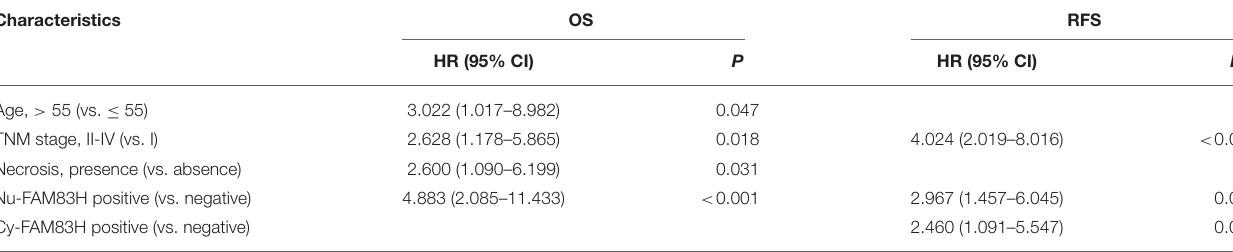
TABLE 4 | Multivariate Cox regression analysis for the overall survival and relapse-free survival of clear cell renal cell carcinomas. Characteristics OS RFS HR (95% CI) P HR (95% CI) P Age, > 55 (vs. ≤